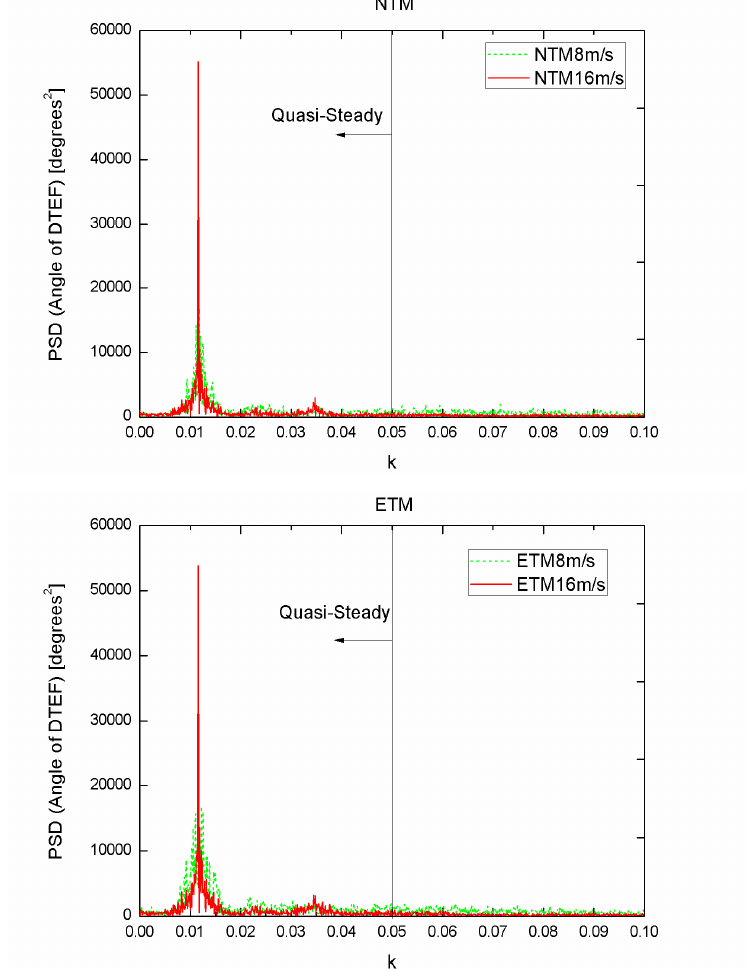
Figure 4. DTEF deflection spectrum.